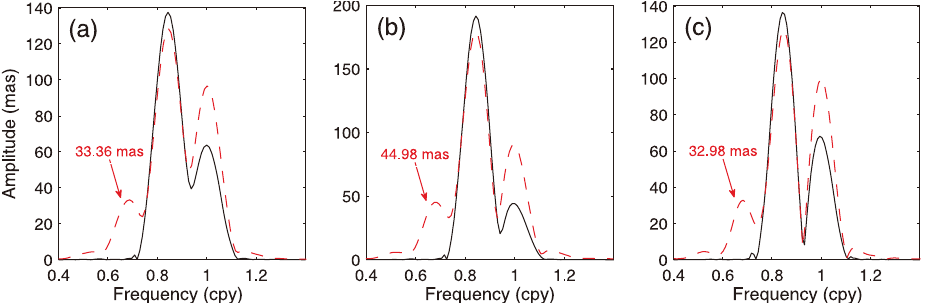
Figure 7. The amplitude spectra of the synthetic series without using EEMD. (a) , (b) , and (c) for the x -component of the 1962–1977, 1978–1994, and 1995–2013 series, respectively. The black curves indicate the results without considering the frequency modulation of CW, whereas the red dashed curves are the corresponding results when considering the frequency modulation of CW, with the modulation index M = 0 .